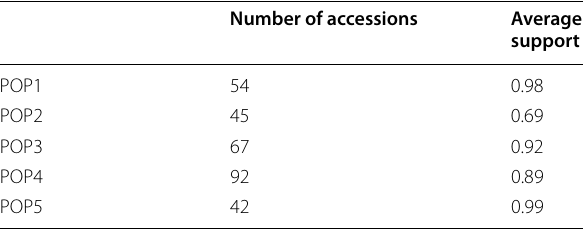
Table 2 Number of accessions and support of clustering assignment from bootstrapping for each population